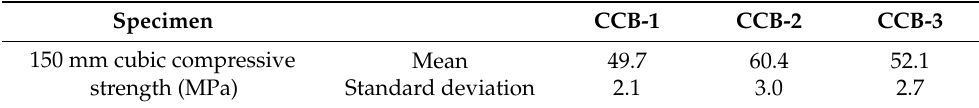
Table 4. Material properties of the C50 concrete coupons (in units of MPa).